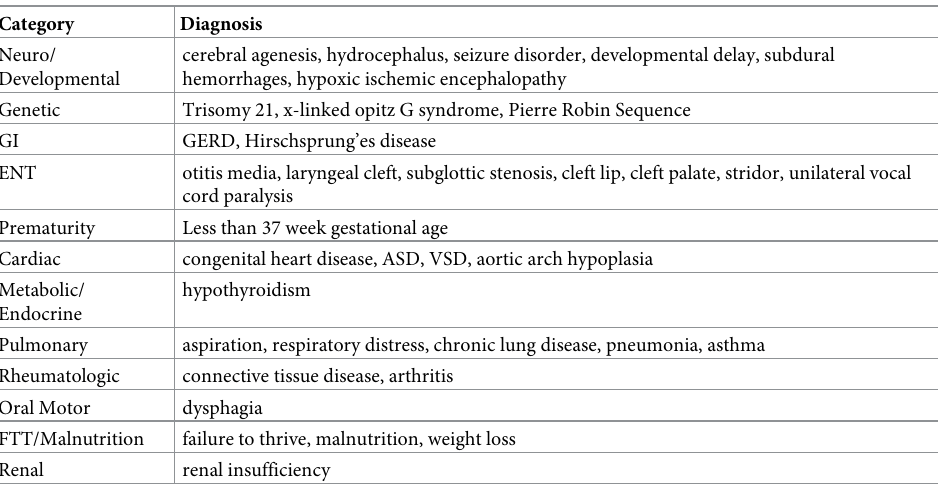
Table 1. Diagnostic